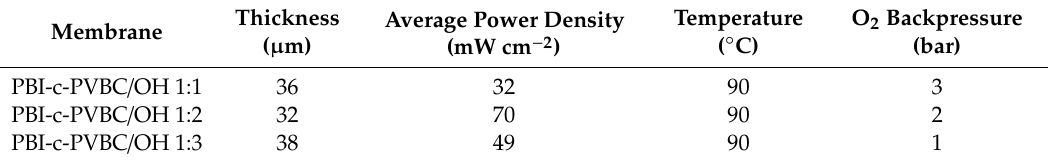
Table 2. PBI-c-PVBC / OH membranes of di ff erent molar ratios and the obtained DEFC average peak power density under various O 2